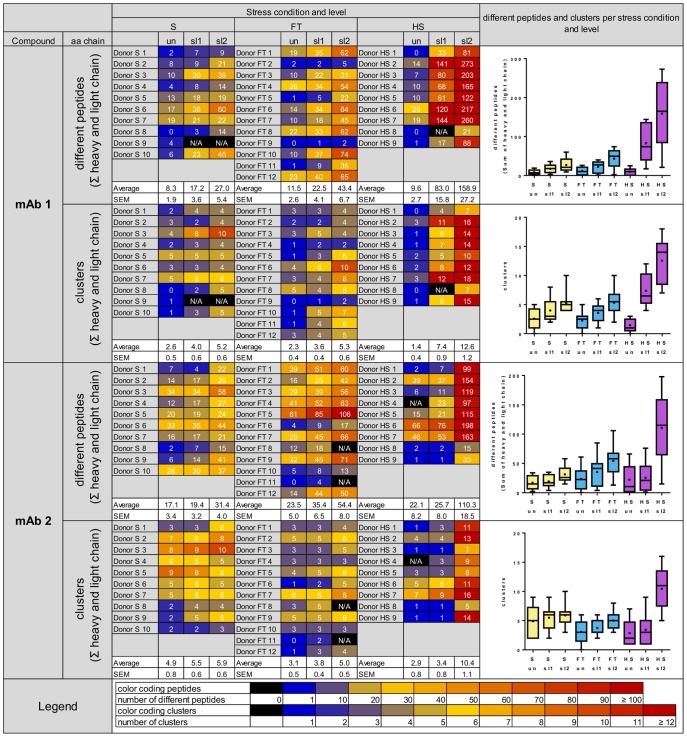
MAPPs results summary.Left: Heat map visualization of the number of different peptides and clusters (as sum of heavy and light chain) for both model antibodies mAb1 and mAb2 for all stress conditions S, FT and HS as well as stress levels un, sl1and sl2. Cell colors are reflecting the number of different peptides and clusters. Right: Box and whisker plot of the number of different peptides and clusters for the different mAbs, stress conditions and stress levels. The boxes extend from the 25th to 75th percentiles and the whiskers are plotted from the min to the max value. The median is indicated as a line and the mean as a dot within a box. HS: aggregates generated by heat and shake stress, FT: aggregates generated by freeze and thaw stress, S: aggregates generated by shear stress, mAb1: monoclonal antibody 1, mAb2: monoclonal antibody 2, un: unstressed, sl1: stress level 1, sl2: stress level 2.